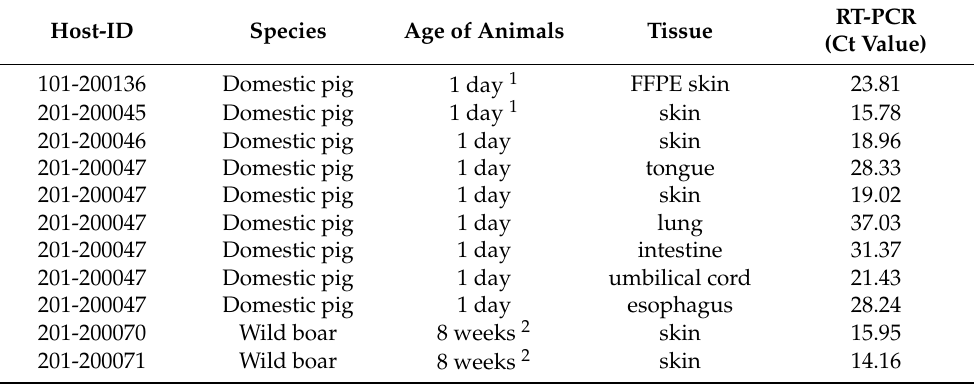
Table 1. List of swinepox virus infected tissue samples from domestic pigs and wild